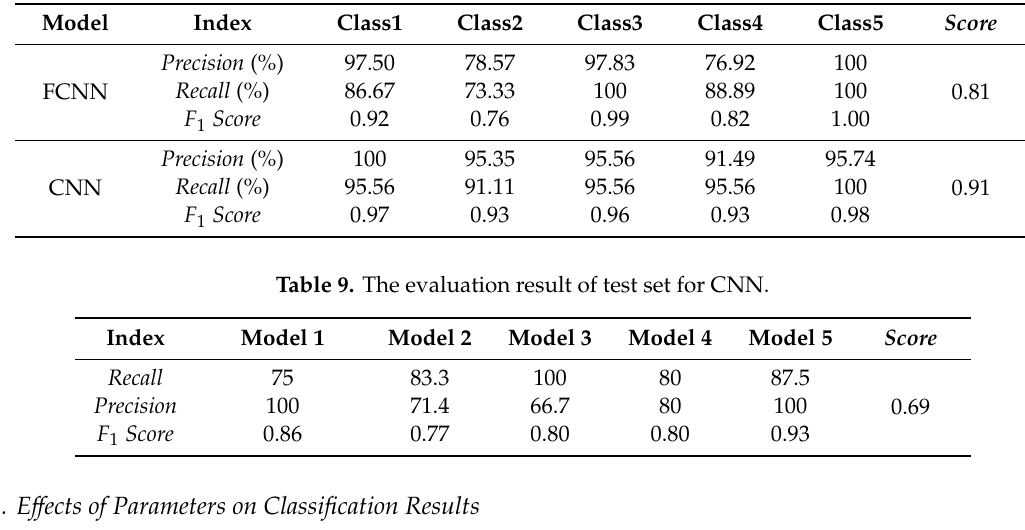
Table 8. The evaluation result of FCNN and CNN on validation set.